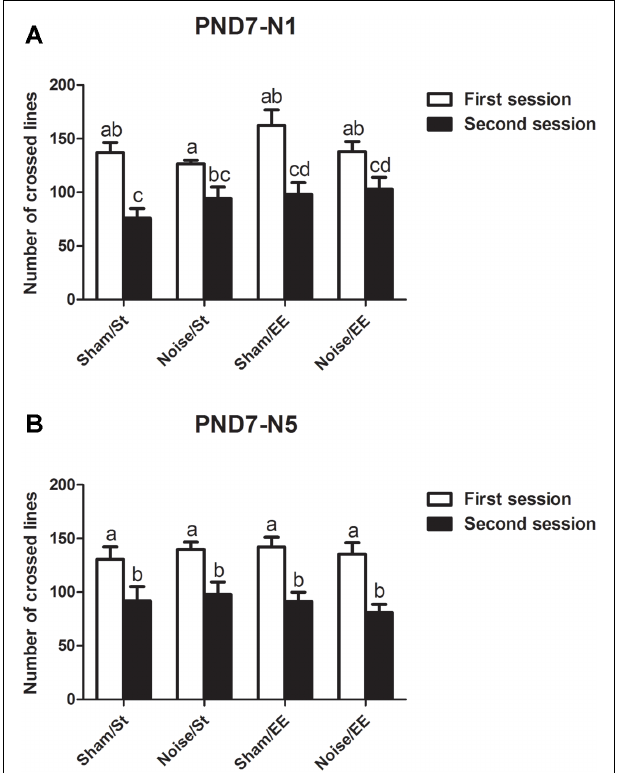
FIGURE 4 | Number of lines crossed in the first and second session of the OF by PND28 animals exposed to noise at PND15. (A) PND15 animals exposed according to N1; (B) PND15 animals exposed according to N5. Sham: non-exposed animals; N1: single noise exposure; N5: five-daily